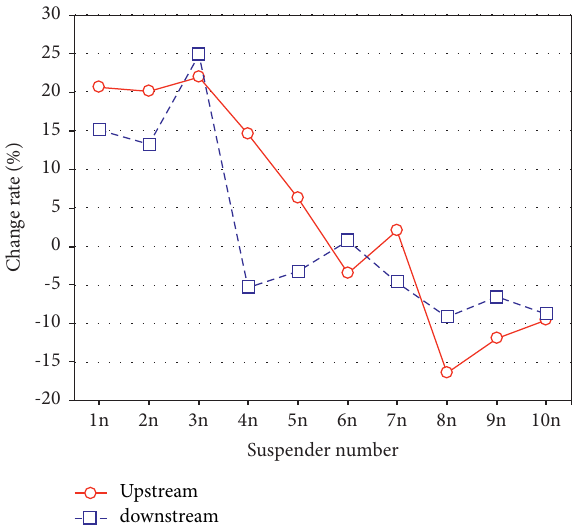
Figure 29: Change rate of suspender cable